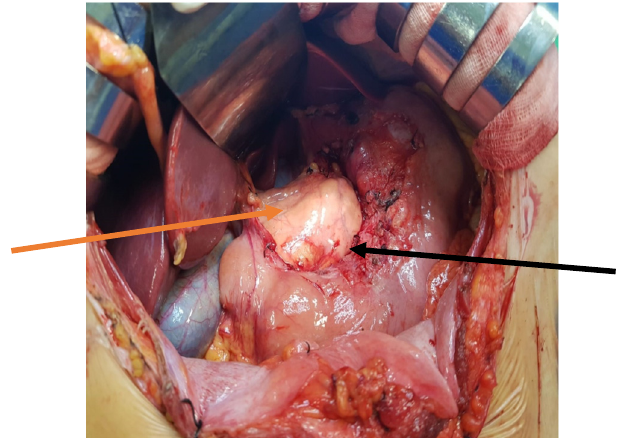
Figure 4. Intraoperative view after tumou r resection of the lesser curvature of the stomach. The arrows indicate the lesser curvature of the stomach (black arrow), and the front surface of the pancreas (orange arrow).